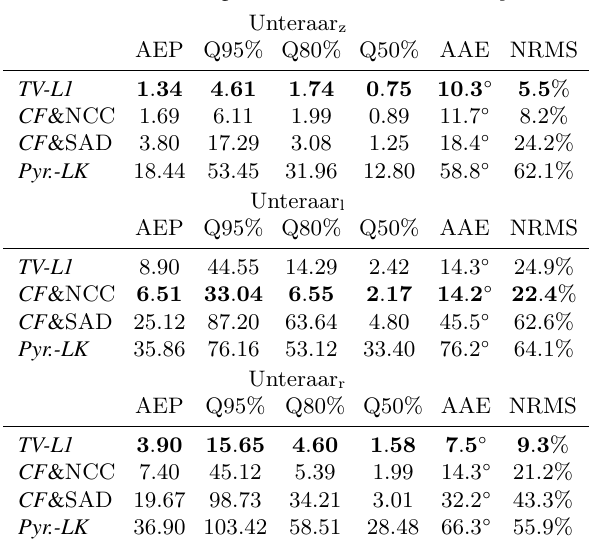
Table 2: Evaluation using different error metrics. (unit: pixel=m) Unteraar